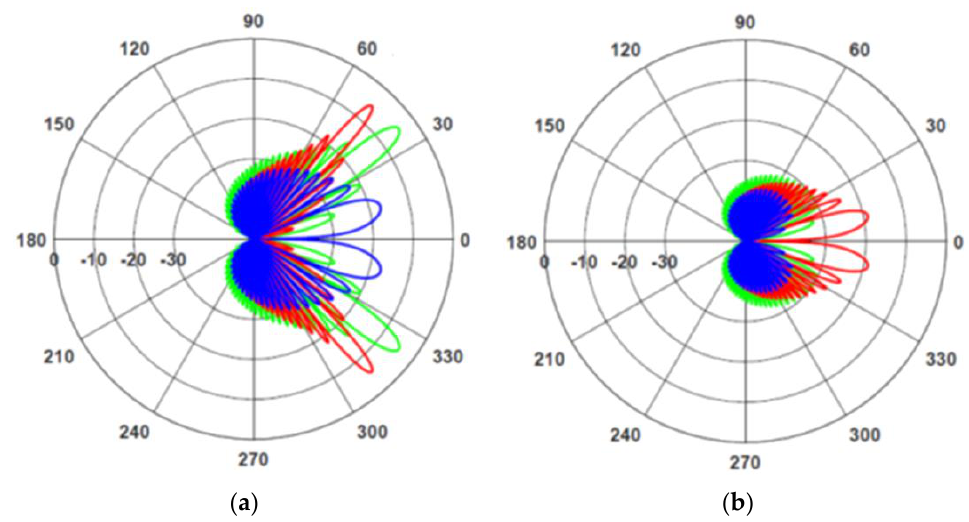
( a ) ( b ) Figure 4. The elementary radiation patterns of the lines 0   (green), 0 R     (red), and Figure 4. The elementary radiation patterns of the lines ω = ω 0 (green), ω = ω 0 + Ω R (red), and     (blue) in logarithmic scale for different values of phase shift. / 2 15 , kl  ω = ω 0 − Ω R (blue) in logarithmic scale for different values of phase shift. kl /2 = 15 π , Ω R = 0.2 ω 0 . 0 R ( a ) ϕ = 0.8; ( b ) ϕ = 0.8  ; ( b ) 1.2  . 0.2   . ( a ) 0 R